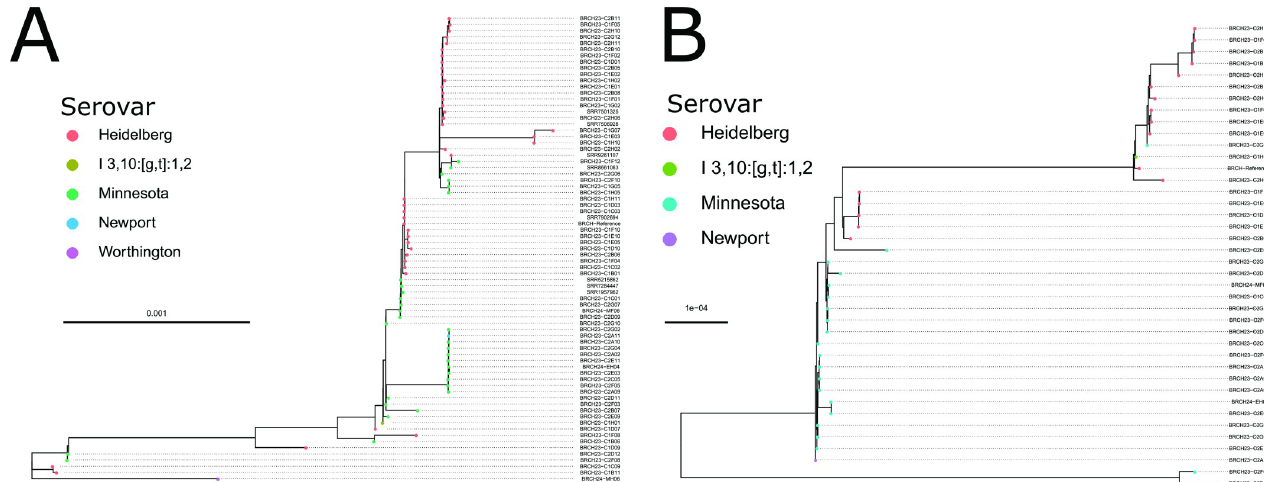
Fig 5. Phylogeny of sul2 , tetA and/or bla CMY-2 carrying IncC plasmids in selected isolates. Selected isolates from imported Brazilian raw chicken and food products tested in the UK and chicken obtained in Brazil. (A) Maximum likelihood phylogenetic tree of 67 genomes identified with an IncC plasmid. Genomes were selected from Brazilian samples collected from poultry. Nodes are coloured by predicted serovar as indicated in the key. (B) Maximum likelihood phylogenetic tree of 39 genomes identified with an IncI1 plasmid. Genomes were selected from Brazilian samples collected from poultry. Nodes are coloured by predicted serovar as indicated in the